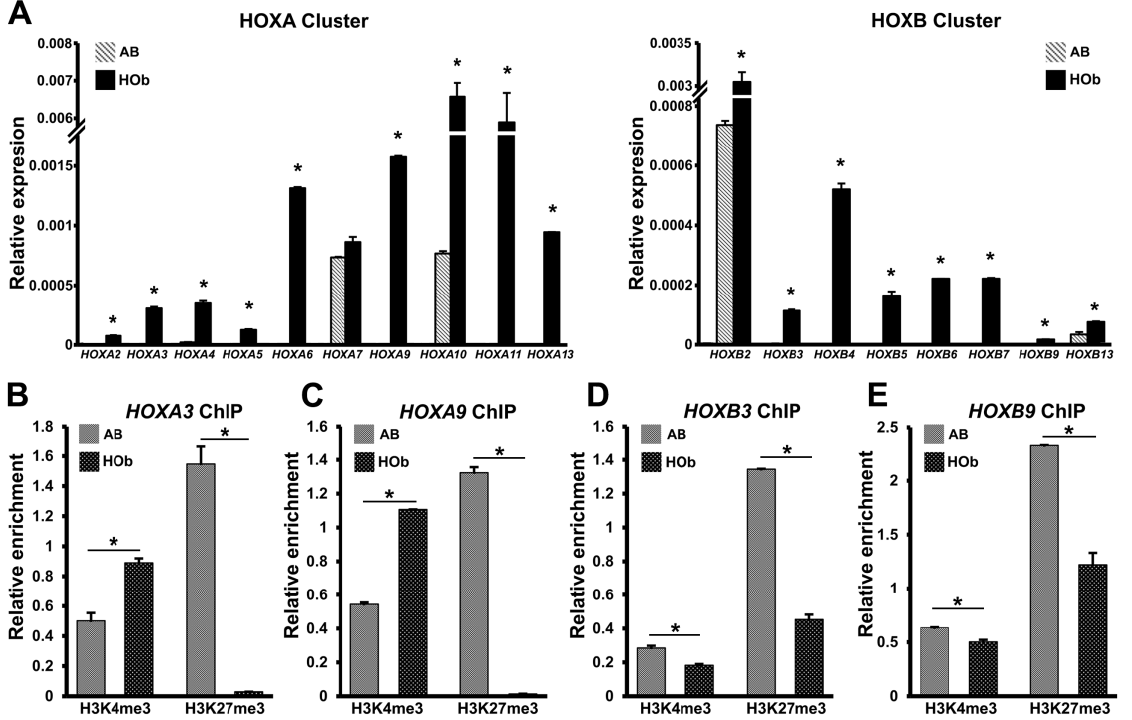
Figure 5. Comparison of HOX gene expression in craniofacial bone and skeletal bone progenitors. ( A ) q-PCR analysis comparing HOX gene expression from HOXA and HOXB clusters in human alveolar bone progenitors (AB) and human osteoblasts (HOb). Absolute values were graphed to